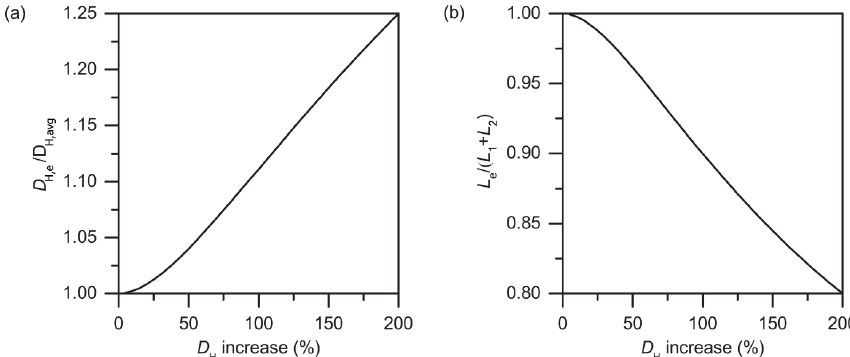
Figure 4. (a) D H,e /D H,avg and (b) L e /(L 1 + L 2 ) for different relative increases in D H when L 1 = L 2 . The D H,e for a flow path with two sections of different D H is generally more heavily weighted toward the section with a larger D H , and a larger increase in D H produces a larger D H,e . The L e for a flow path with two sections of different D H is always less than L 1 + L 2 , and a larger increase in D H results in a smaller L e .